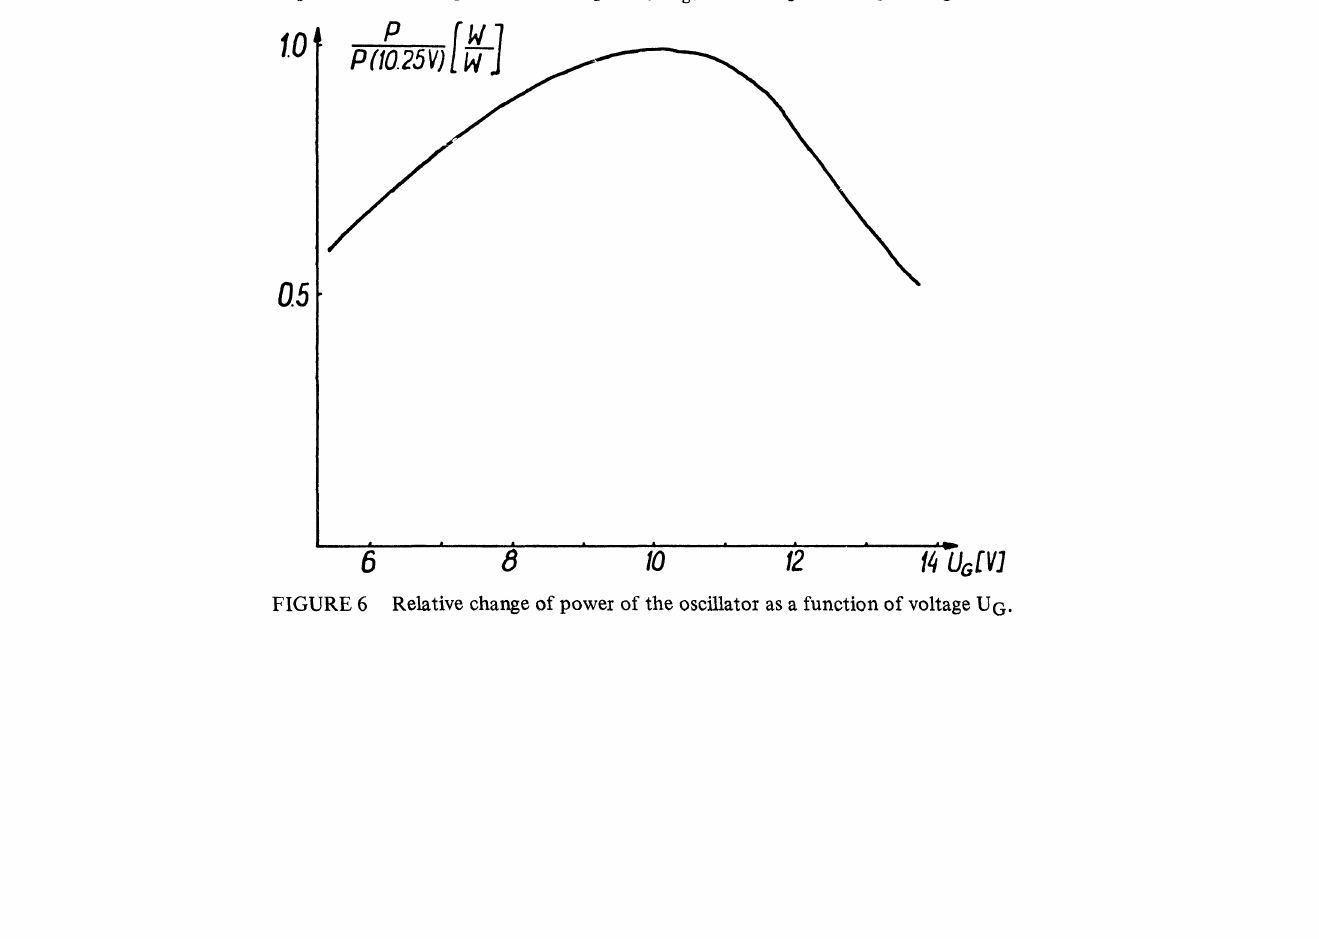
FIGURE 6 Relative change of power of the oscillator as a function of voltage U